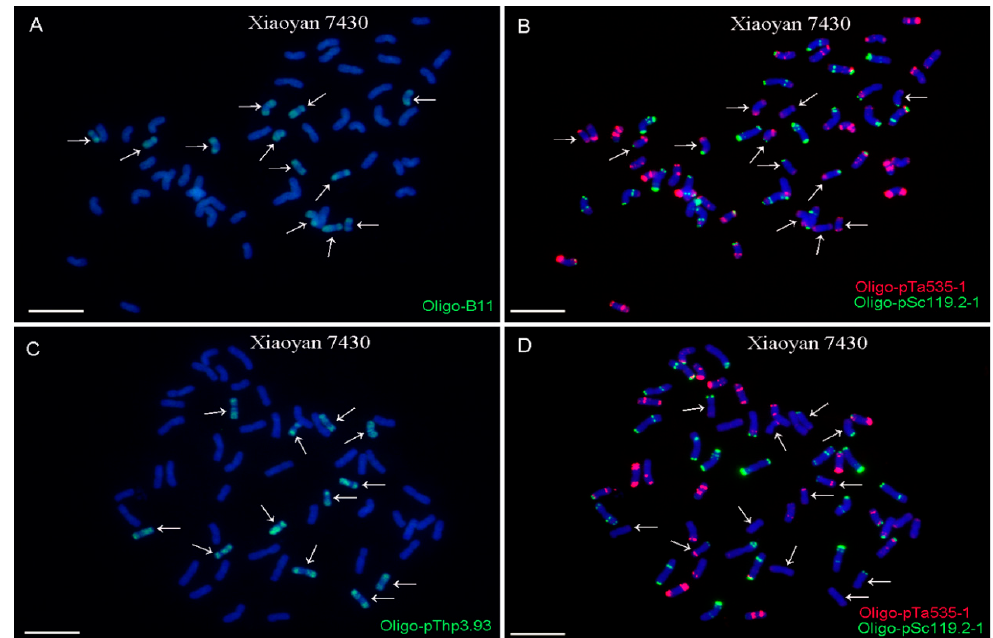
Figure 3. ND-FISH analysis of the root tip metaphase chromosomes of Xiaoyan 7430 using the Oligo-B11 (green), Oligo-pThp3.93 (green), Oligo-pTa535-1 (red) and Oligo-pSc119.2-1 (green) as probes. ( A ) and ( B ) are the same cell, and ( C ) and ( D ) are the same cell. Arrows indicate the Th. ponticum chromosomes that carry signals of Oligo-B11 ( A ) and Oligo-pThp3.93 ( C ). Chromosomes were counterstained with DAPI (blue). Scale bar: 10 μ m.